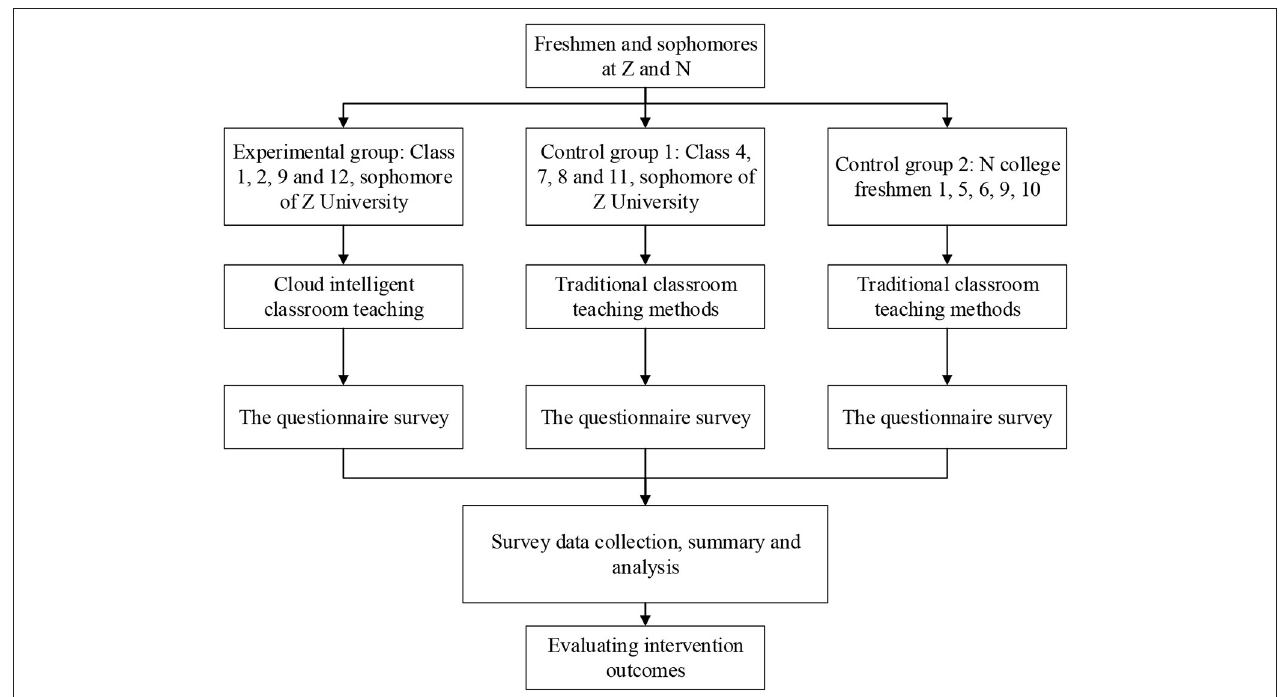
FIGURE 3 | Research ideas and